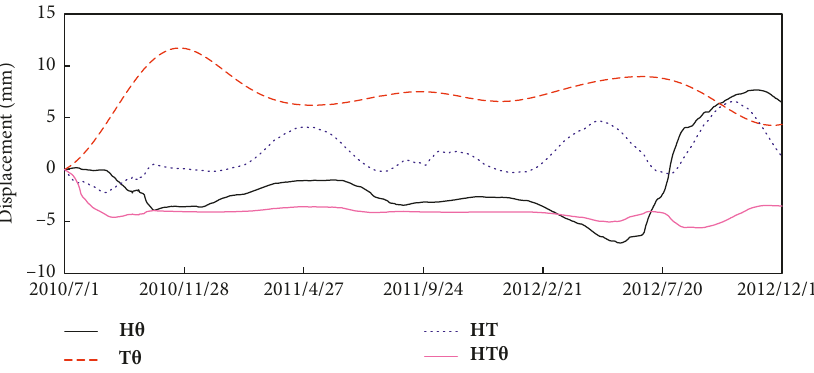
Figure 9: Coupling component hydrographs of the KPLS model for radial displacement.